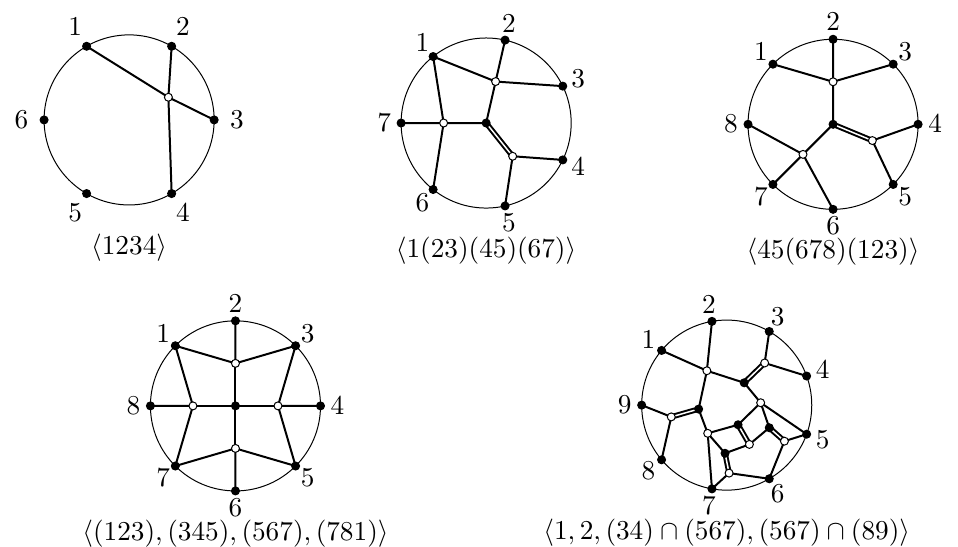
Figure 9. Examples of webs, and their corresponding invariants (cluster variables), for the five different basic types (defined in the text) of rational symbol letters that are known to appear in SYM theory.